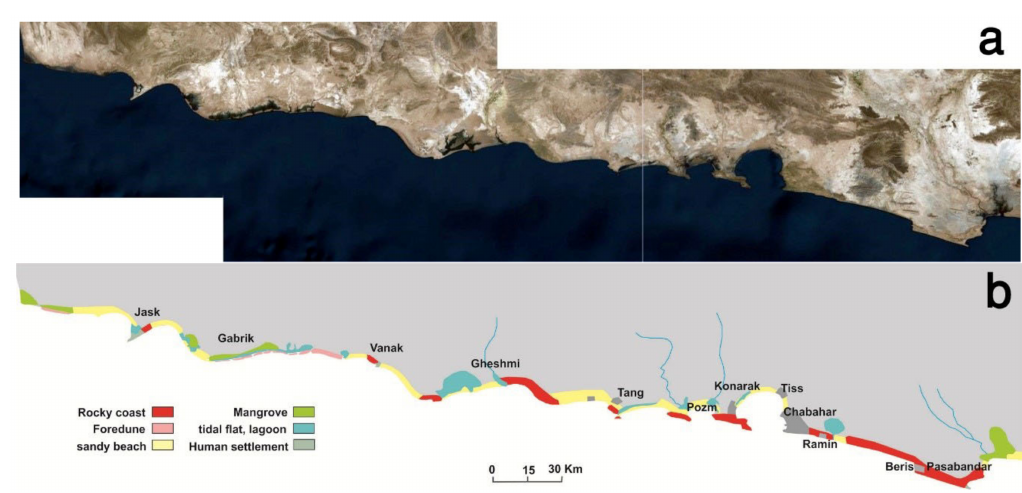
Figure 2. Landsat-8 image ( a ) and main geomorphological features and population centers of the Iranian coast of Makran ( b ).